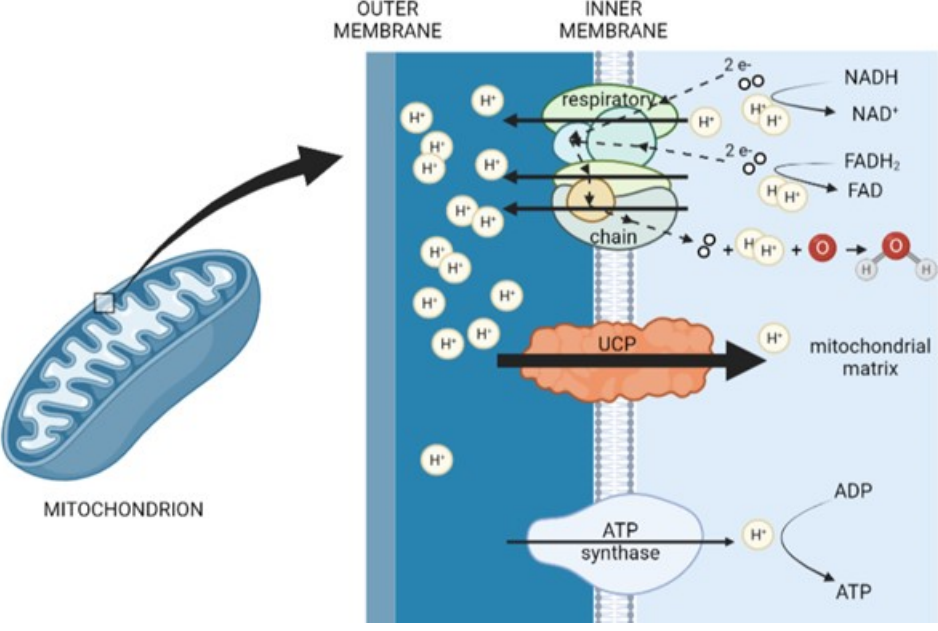
Figure 1. A schematic overview of UCP function and localization in a mitochondrion (created with BioRender.com, (accessed on 19 January 2022)).